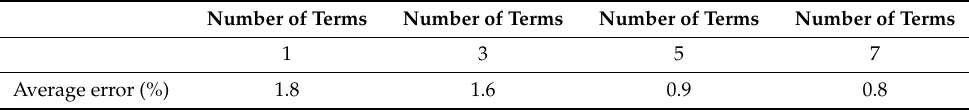
Table 2. Average deviation between experimental and fitted data (PLA, d 1 = 0.09